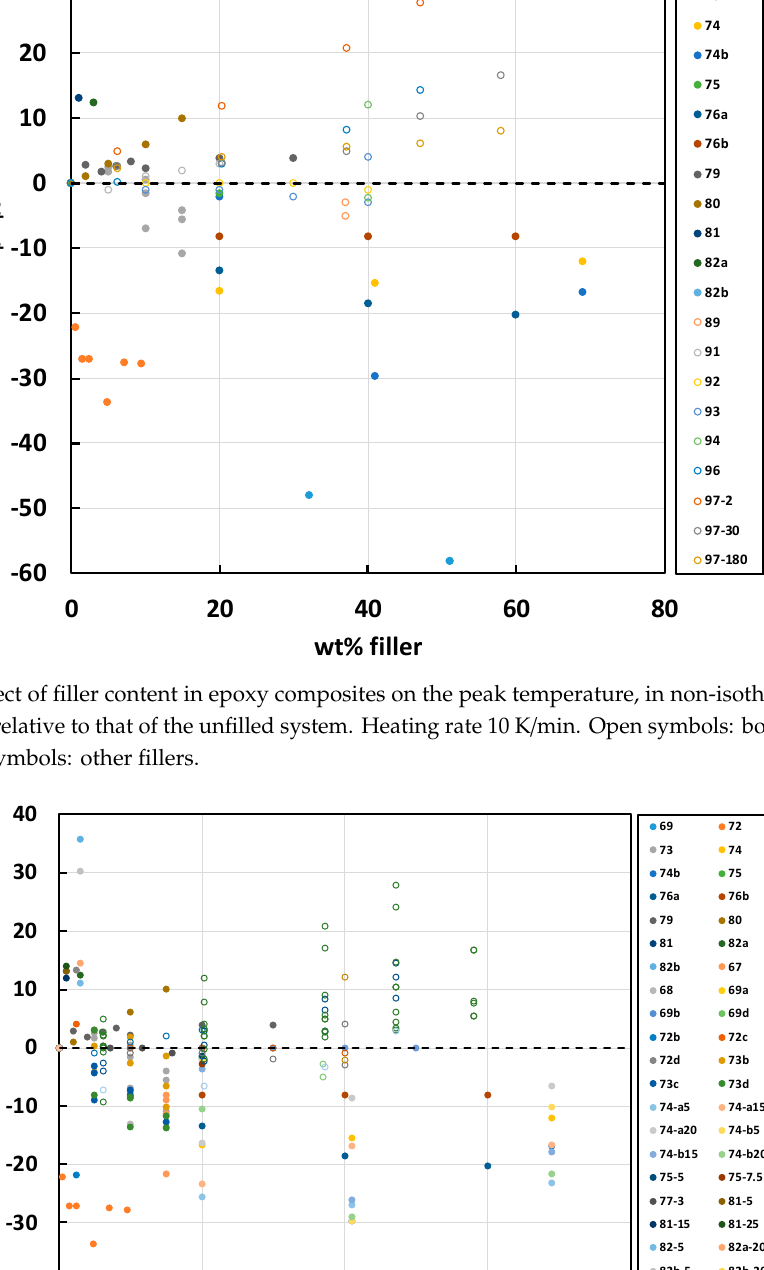
Figure 4. Effect of filler content in epoxy composites on the peak temperature in non-isothermal cure, relative to that of the unfilled system. No distinction is made here between results obtained at different heating rates. Open symbols: boron nitride filler; filled symbols: other fillers.